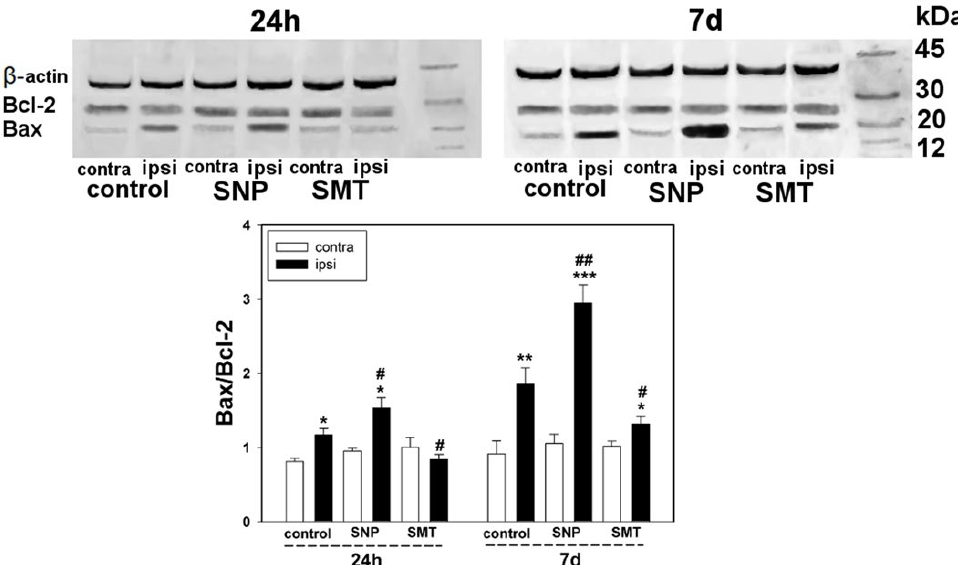
Figure 6. Western blot analysis. The effect of NO donor (SNT) and selective inhibitor (SMT) of iNOS on the Bax–Bcl-2 ratio in the ipsilateral DRG and contralateral DRG, 24 h and 7 days after sciatic-nerve transection. One-way ANOVA. М ± SEM. n = 6. * p < 0.05, ** p < 0.01, *** p < 0.001—ipsilateral DRG with respect to contralateral DRG of the same animal # p < 0.05, ## p < 0.01—ipsilateral DRG with respect to ipsilateral DRG of the control group animal, within the same temporal interval after axotomy.